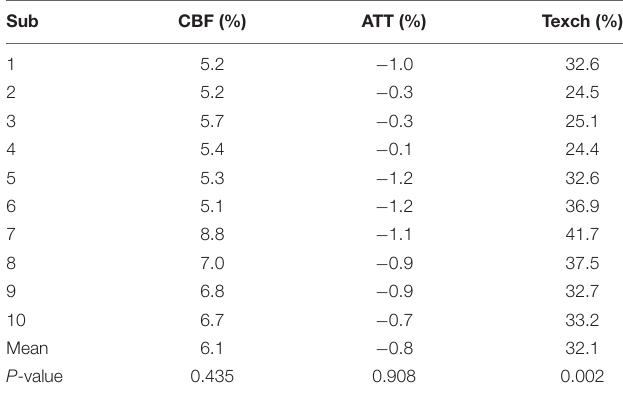
TABLE 1 | Relative difference of estimated CBF, ATT, and Texch between the models, relative to the two-compartment model.